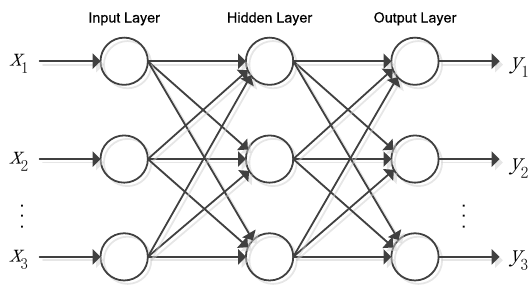
Figure 4. The structure of the Back Propagation (BP) neural network.